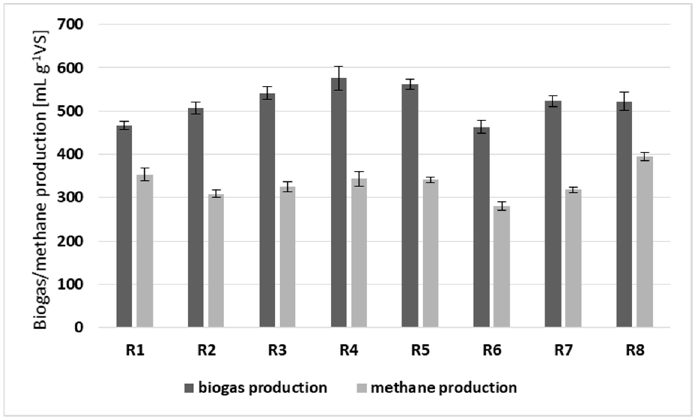
Figure 2. Results in terms of biogas and methane production in the corresponding series (average